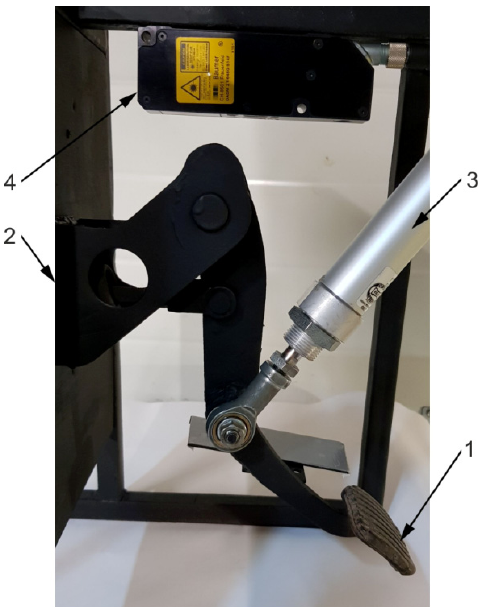
Figure 9. View of the test stand design solution: 1–dual foot brake pedal, 2–brake pedal mechanism, 3–pneumatic actuator, 4–laser sensor.